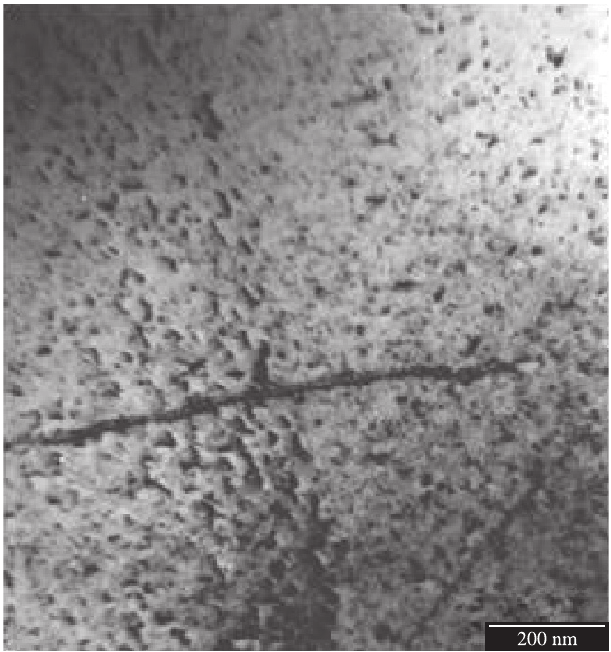
Figure 7. TEM analysis of duplex stainless steel alloy aged for 3000 hours at 300 °C, bright